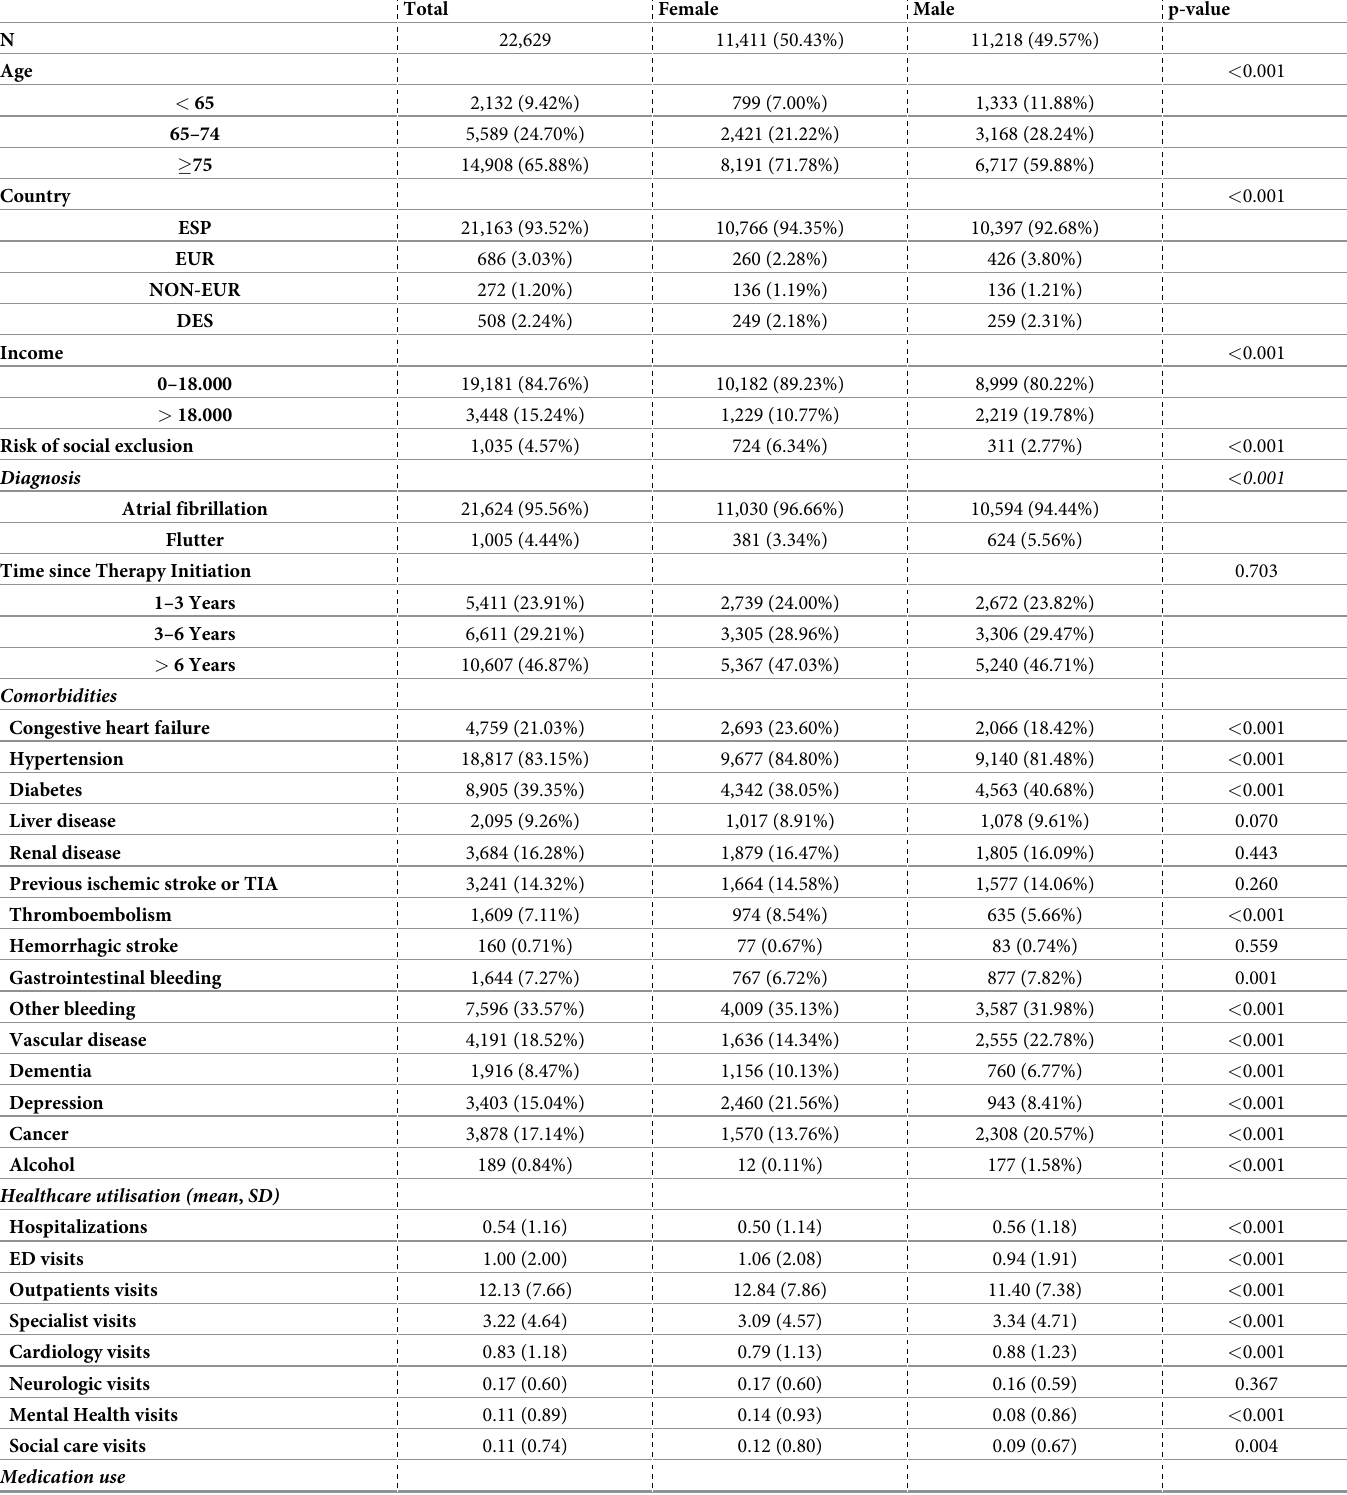
Table 1. Patient characteristics, by sex and for the whole